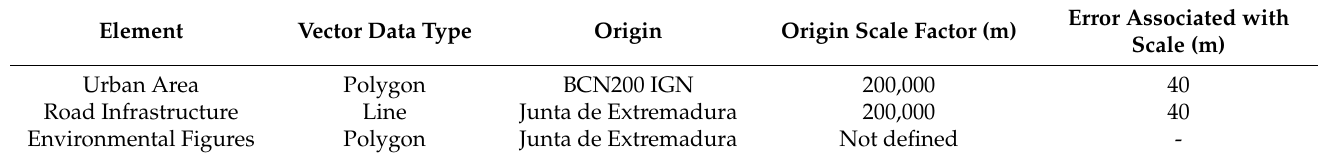
Table 2. Cartographic elements used in the